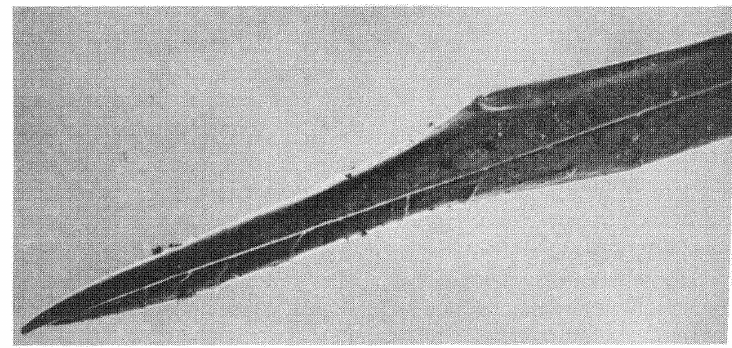
Fig. 10. Cosmiocryptus diplatys, tip in lateral